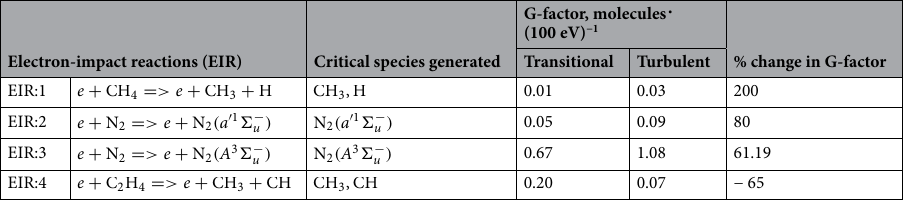
Table 3. G-factor of critical species contributing further to CH 4 consumption reactions, generated from electron-impact reactions.